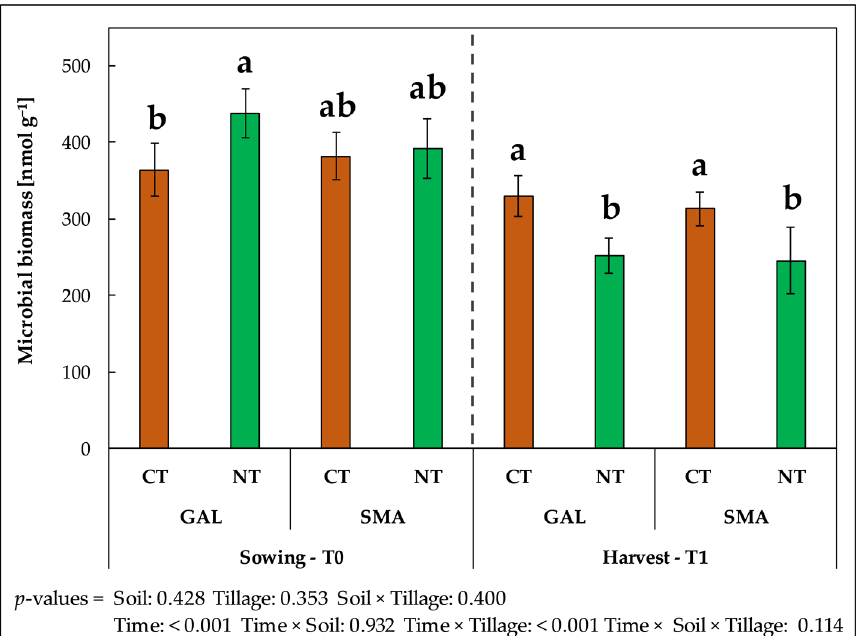
Figure 4. Effect of soil (GAL and SMA), tillage system (CT, in brown, and NT, in green), sampling time (sowing—T0 and harvest—T1), and their interaction on soil microbial biomass (MB). Reported values are means ( n = 4) ± SE (bars). Different letters indicate significant differences within each sampling time (Tukey’s HSD test at p <0.05) between treatments (Soil × Tillage).